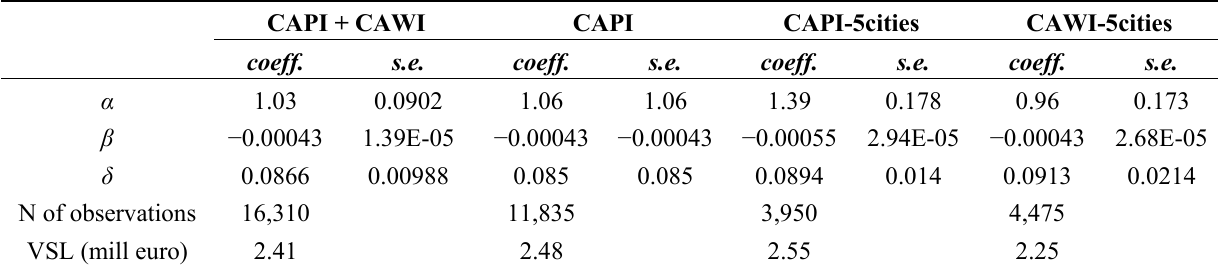
Table 5. Results for different samples of respondents, conditional logit